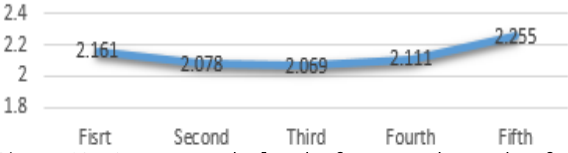
Figure 10. Average path length for network graph